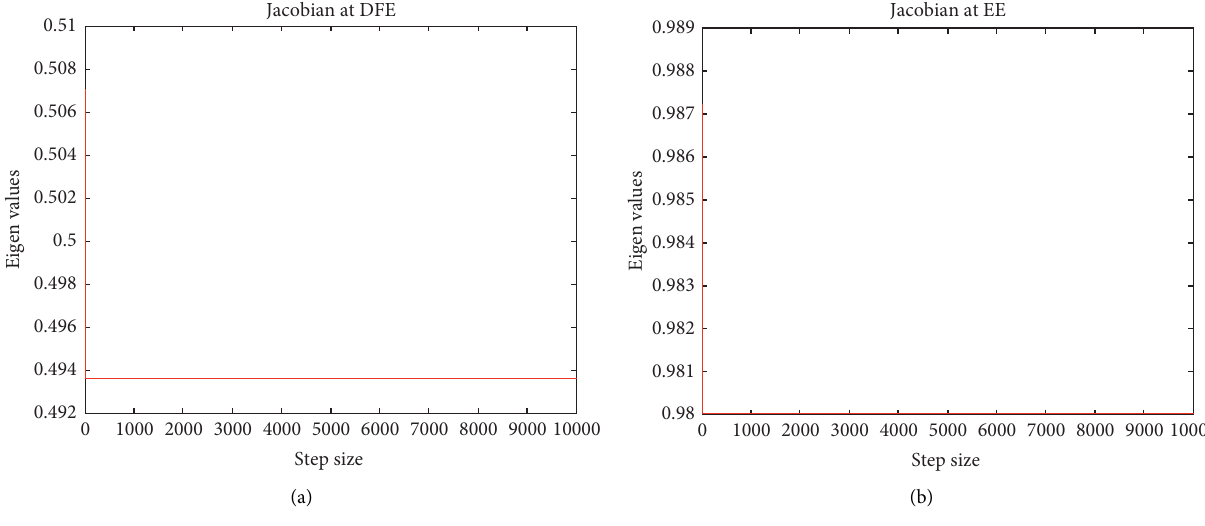
Figure 2: Spectral radius of the Jacobian at equilibrium